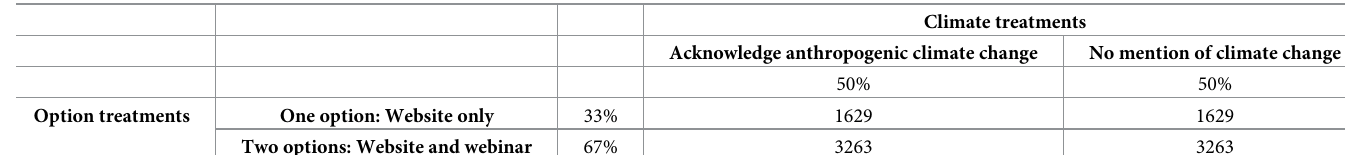
Table 1. Treatment